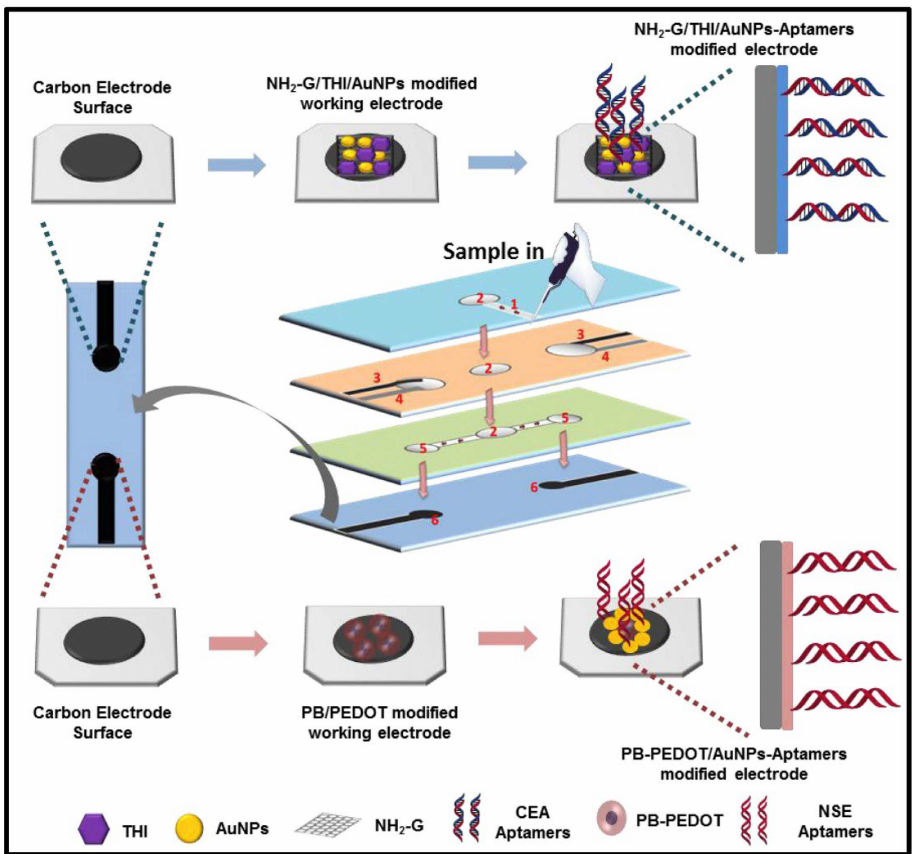
Figure 9. Construction of the electrochemical paper-based aptasensor device; (1) sample inlet area (2) filter (3) screen-printed counter electrode; (4) screen-printed reference electrode; (5) detection zone; (6) screen-printed working electrode. Reprinted with permission from Ref. [96]. Copyright 2019,